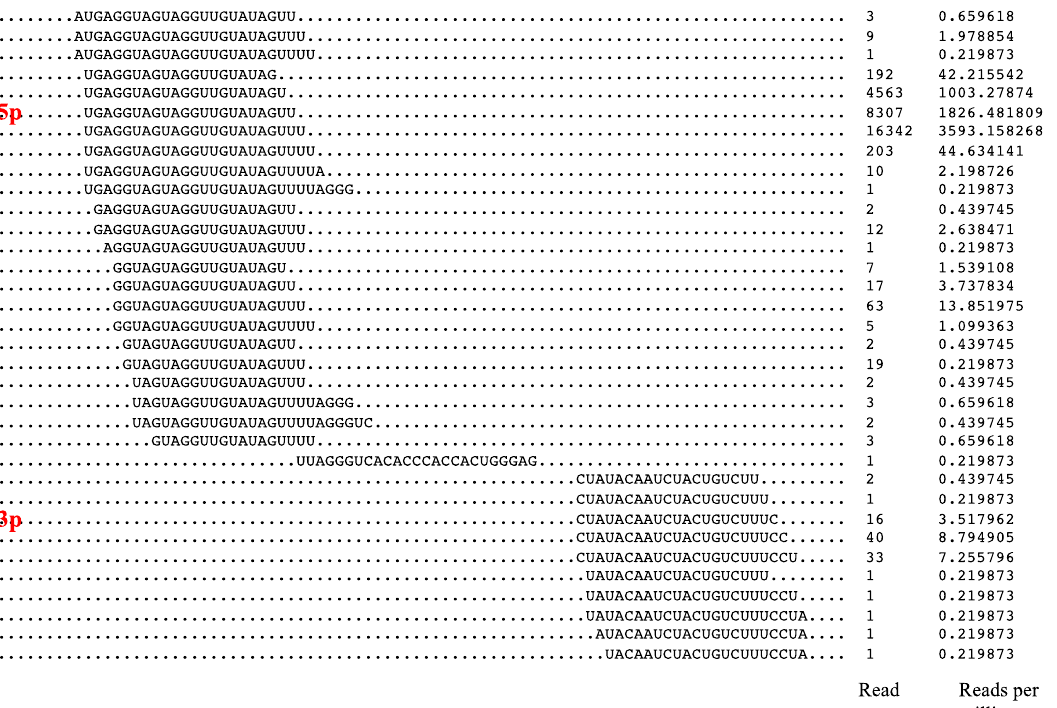
Figure 1. Next Generation Sequencing (NGS) reads alignments of hsa-let-7a-1 miRNA isoforms (isomiRs). A small RNA NGS library from a gastric cancer cell line (AGS